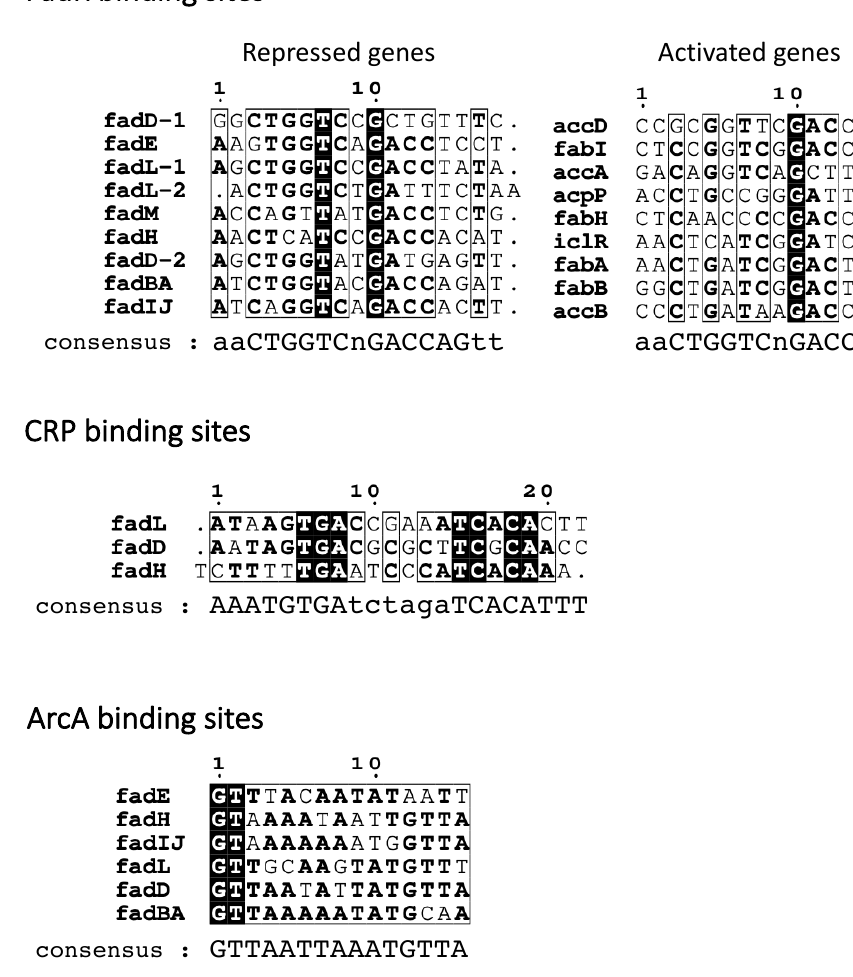
Figure 12. Binding sites of FadR, CRP, and ArcA in fad promoters. The binding site sequences were retrieved from the references given in Figure 9. The consensus sequences were retrieved from the Ecocyc website [107]. The alignments were formatted using the ESPrit 3.0 server [108]. Strictly conserved and more than 60% conserved nucleotides are highlighted in black and bold, respectively.